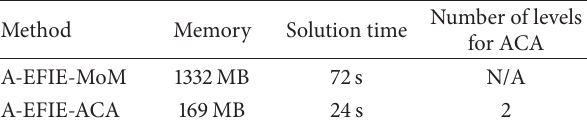
Table 1: The memory requirement and solution time in bistatic RCS computation for the sphere.